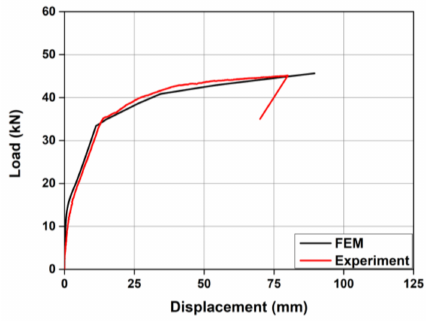
Figure 9. Comparison of load-displacement curves for SL-60S-4.